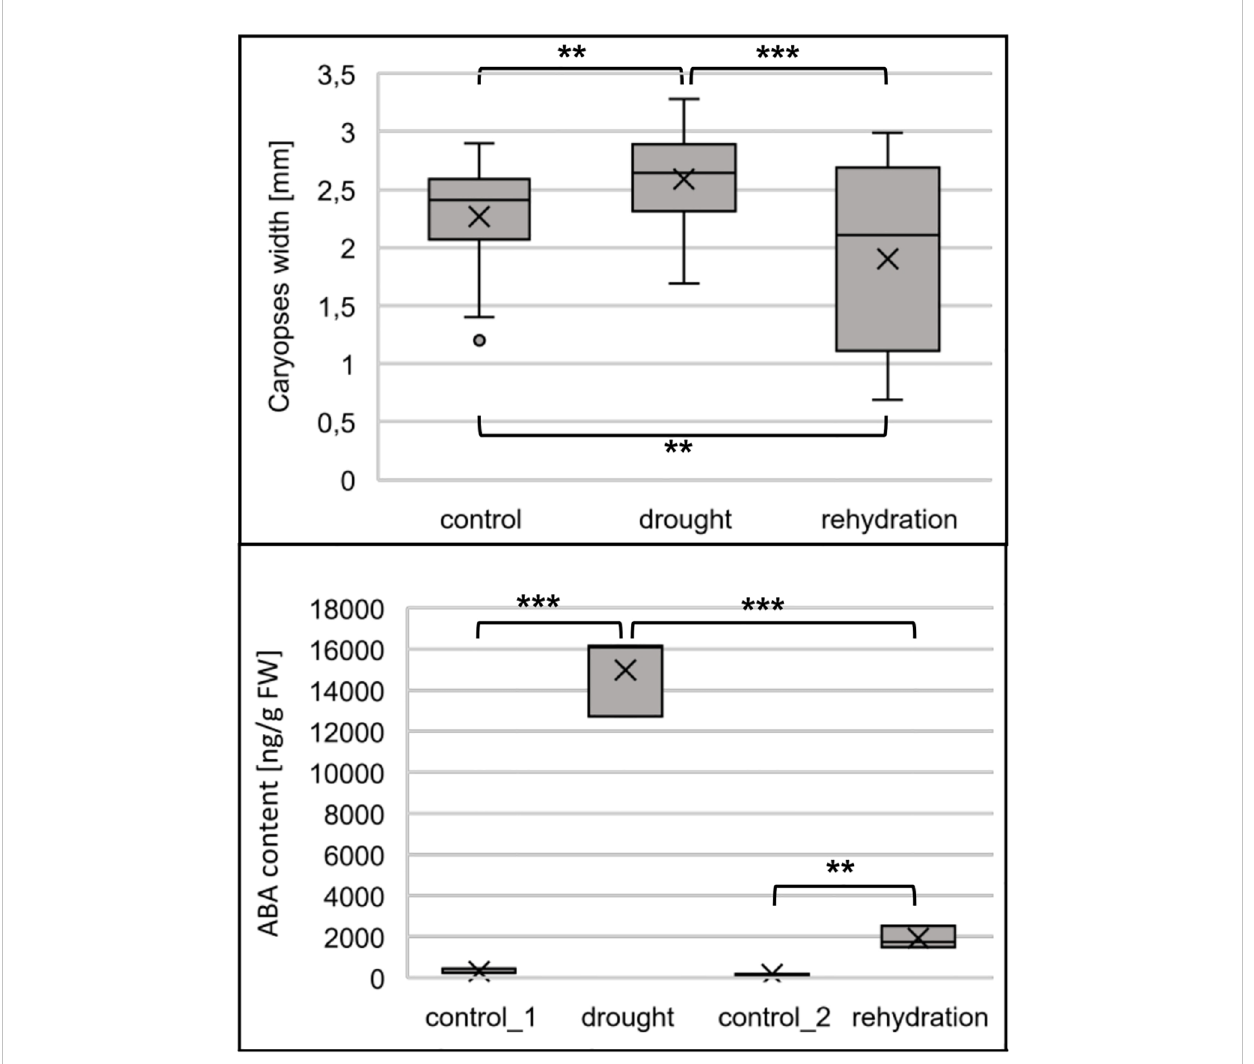
FIGURE 7 Drought accelerates fl owering in barley. Upper panel, caryopses developing in drought- stressed barley are larger than control ones. Caryopses isolated from rehydration-treated plants are smaller. Lower panel, barley reacts to drought with elevated ABA biosynthesis; the biosynthesis is decreased after rehydration. The signi fi cance of the presented differences were tested with two-tailed Student ’ s t -test (***p ≤ 0.001, **p ≤